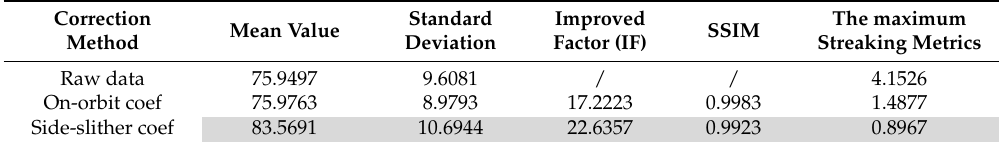
Table 3. Comparison of quantitative values of the water images.